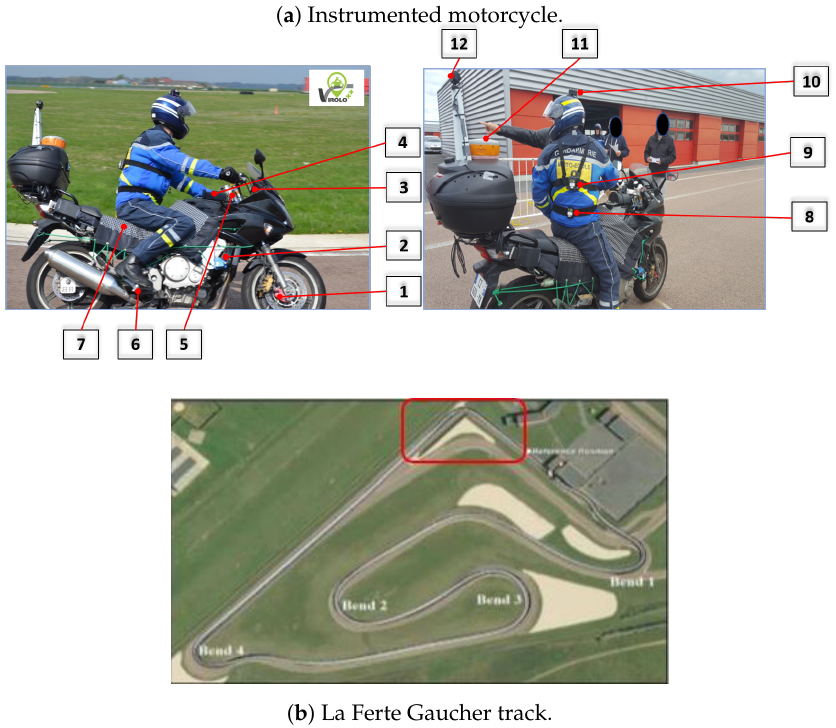
Figure 1. The heavily instrumented motorcycle and the La Ferte Gaucher